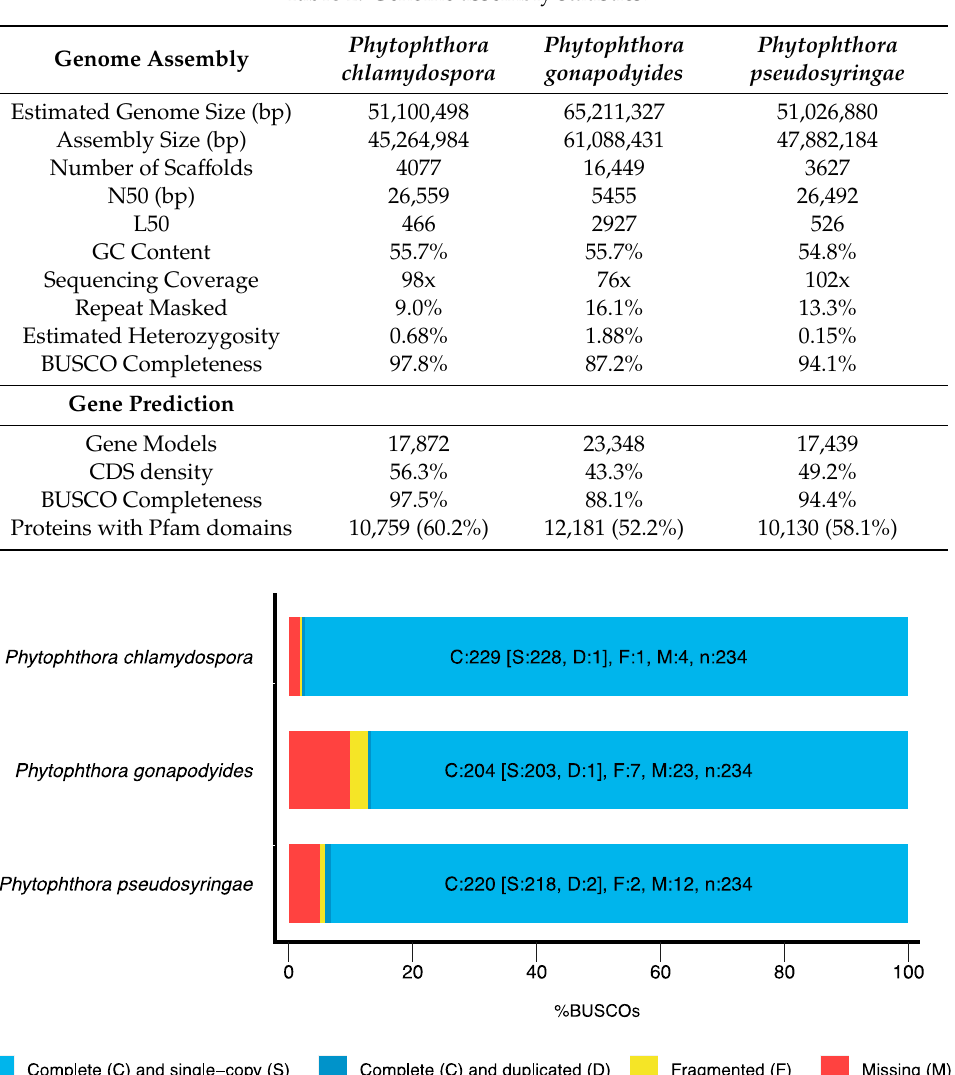
Table 2. Genome assembly statistics.